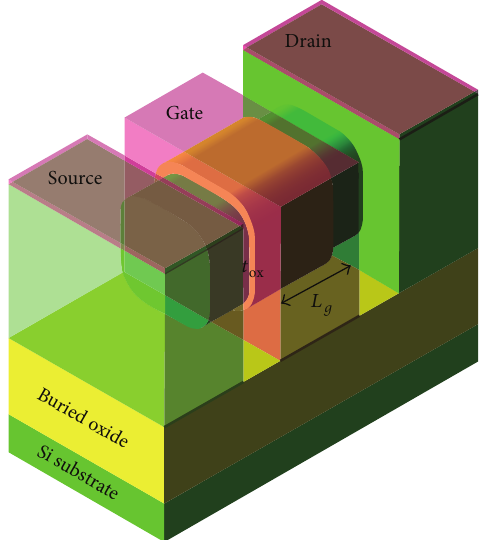
Figure 1: The schematic diagram of the QG MOSFET.